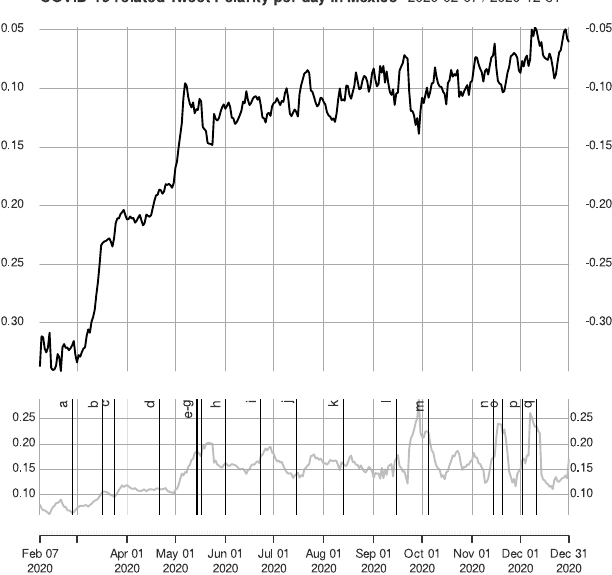
Figure 5. Year–Long time series of daily averaged RoBERTa’s compound sentiment polarity of COVID-19- related tweets, detrended, with its variance and significant events in Mexico . This time series is based on the same dataset collected [6] and restricted to Mexico from 2 February to 31 December 2020. Data were smoothed over via a 7-day rolling means. Variance is also included for readability, as well as significant events found to cause an impact